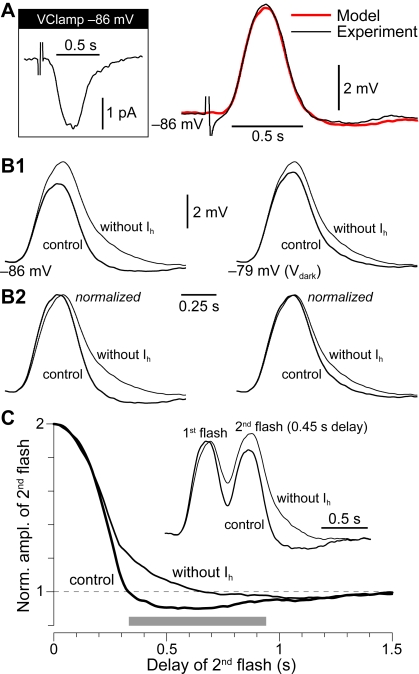
Ih quickens the dim flash response of RBCs and sharpens the detection of event coincidence.A, The band–pass filtering of RBCs operates not only on pipette–injected current, but also on light–evoked input. On the left, post–synaptic current (PSC) evoked by dim flash (3× threshold) recorded in voltage–clamp (−86 mV holding, average of 79). The same PSC was fed to the simplified model (see Figure 3C, legend) of the RBC under study (linearized at −84 mV, iBP = 1.47). On the right (red trace), the predicted trajectory of post–synaptic potential (PSP) matches the one recorded in current–clamp with the same flash (black trace; membrane potential set at −86 mV by current injection, average of 61). B1, Flash–evoked PSPs predicted by the model at two different membrane potentials in control, and after removing Ih (by setting Gh to 0). In the presence of Ih, peak amplitude is reduced and the return to baseline is anticipated. B2, The latter remains true even after normalizing PSP amplitudes. Thus, the ‘price’ paid in terms of response amplitude reduction by expressing Ih, is more than offset by a faster response of the RBC. C, Graph shows the amplitude of a second dim flash response following a first one with a brief delay (same flash strengths), as predicted by the model at −86 mV in control and after removing Ih. Response amplitude is normalized to that of the same flash given in isolation. Inset shows the normalized voltage trajectories evoked by two flashes 0.45 s apart. For a duration of several hundred ms (indicated by a gray bar) Ih converts temporal summation of near–coincident flash responses (graph values>1) to attenuation (graph values<1).